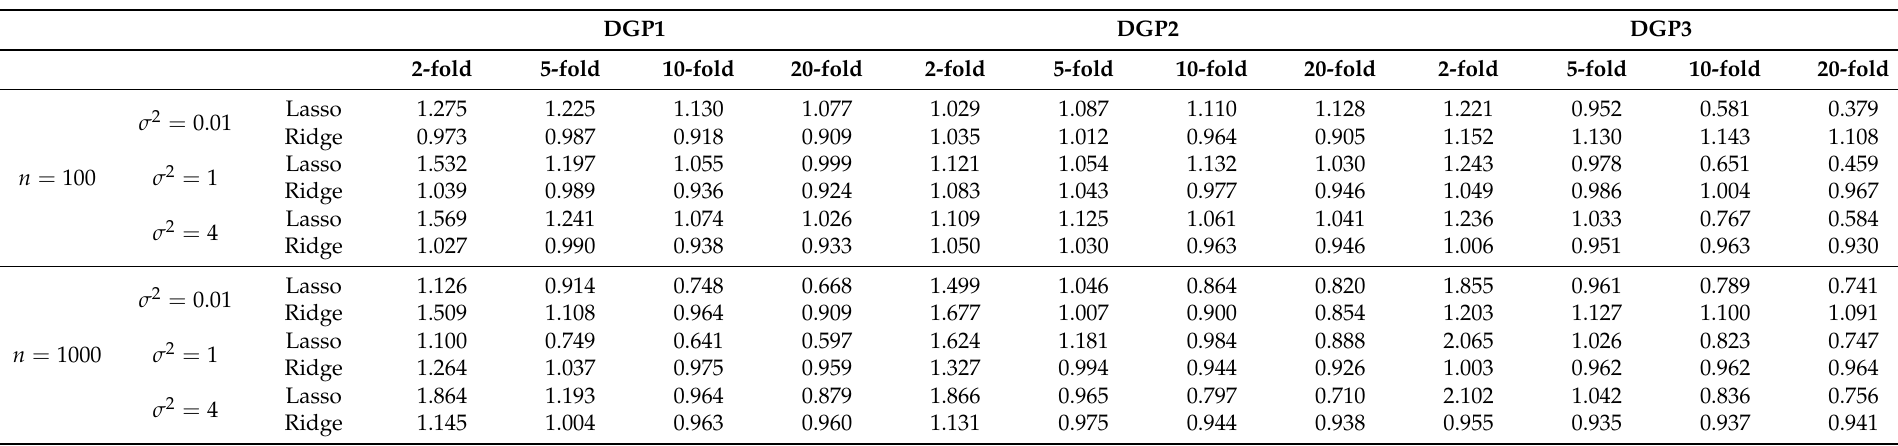
Table A2. Mean ratio of claimed SE and true SD: independent predictors and decaying